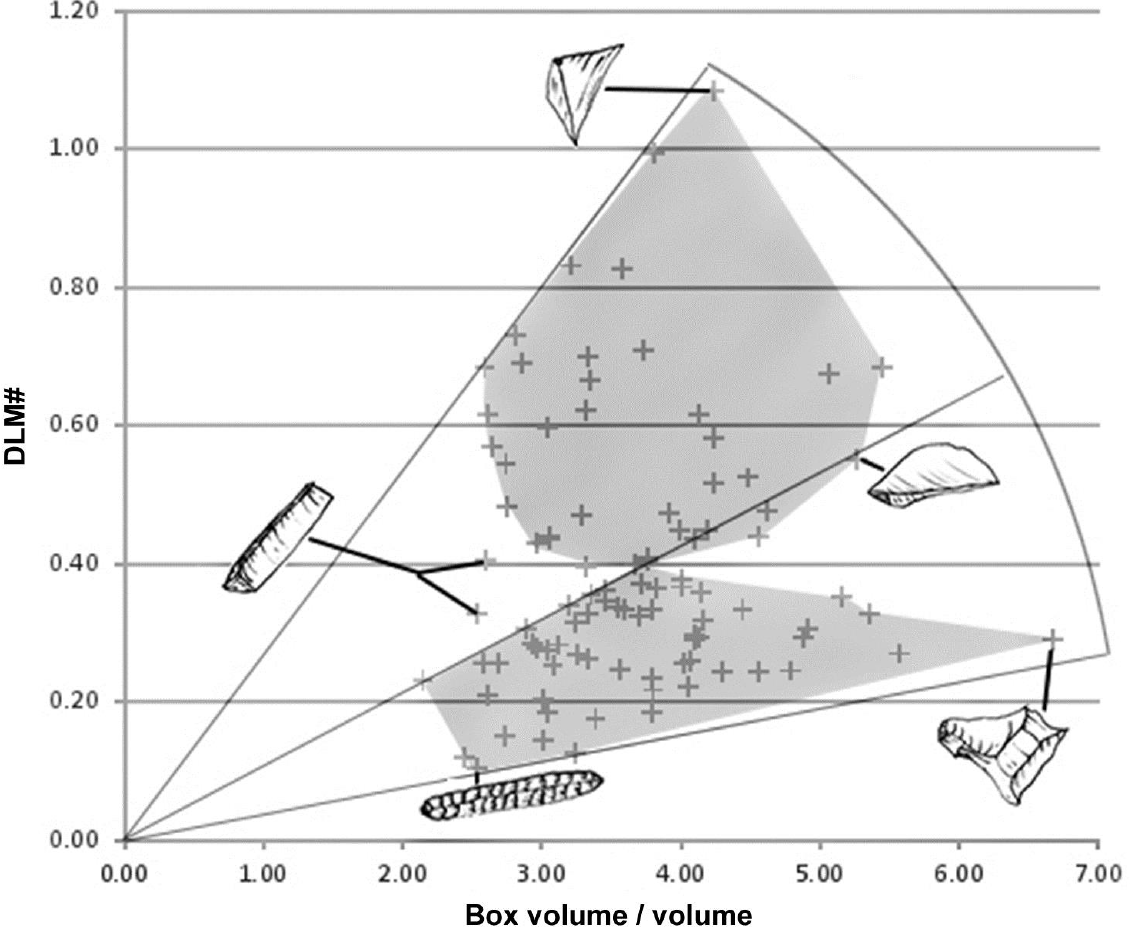
Figure 2: Data mapped as a matrix with the behavioural index (DLM#) on the vertical axis and the volumetric index (box volume divided by volume) on the horizontal axis. Shaded areas of the matrix emphasize how data is separated into two regimes of flake mechanics. The role of flake geometry is illustrated by the morphology represented at selected specific data